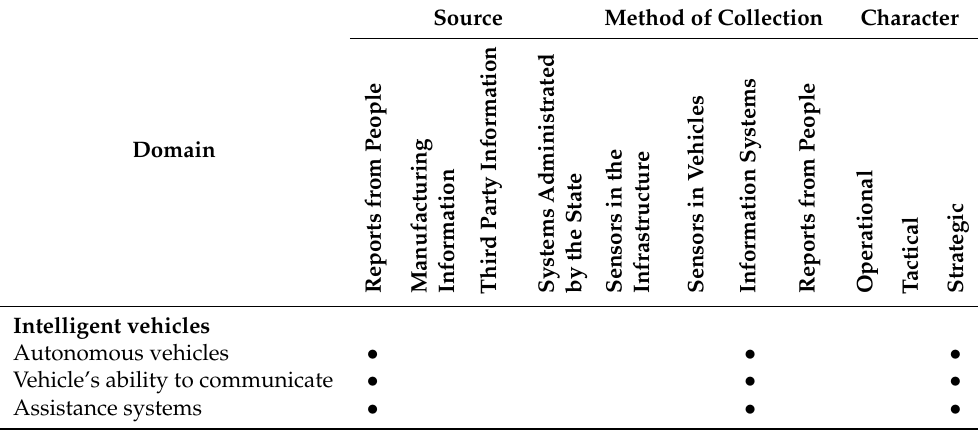
Table 1. Domains according to the categorization of data collected within V2I according to